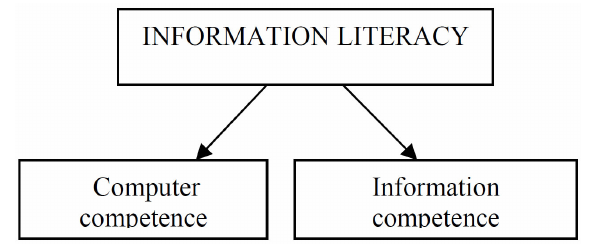
Figure 4. Component of information